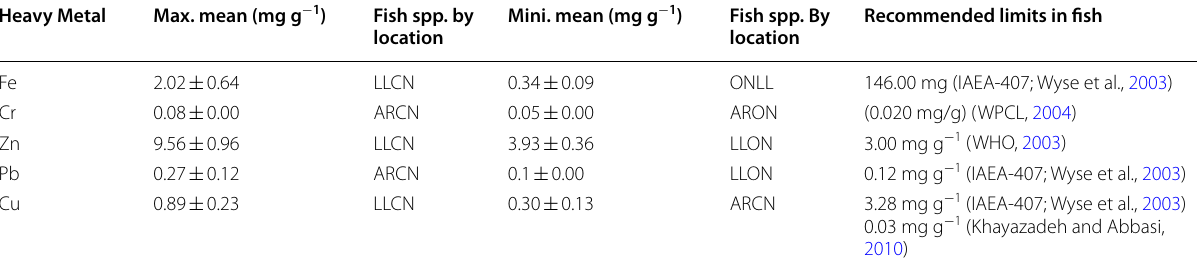
Table 2 Maximum and Minimum Heavy Metals Concentration in Chrysichthys nigrodigitatus and Oreochromis